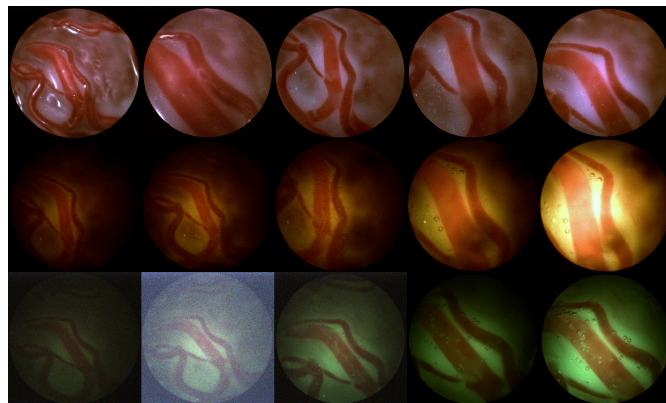
Figure A1. Variations in viewing conditions. Top row left to right: ex-vivo-far, ex-vivo-close, ex-vivo with water-far, ex-vivo with water-nominal, ex-vivo with water-close; Middle row: yellow liquid, bottom row: green turbid liquid; left to right: far-dark, far-nominal, nominal for both, close-nominal, close-bright.